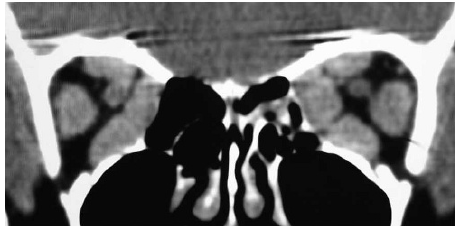
Figure 6 - Coronal CT scan showing orbits with apical crowding due to enlarged extraocular muscles. The right orbit shows effacement of the perineural fat up to 25% of the circumference (grade 1 in Nugent’s score); the left orbit shows no effacement of the perineural fat (grade